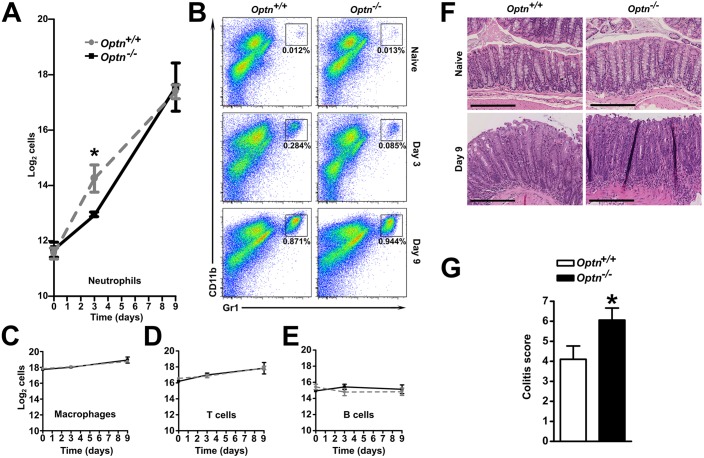
OPTN-deficient mice recruit fewer neutrophils during the early acute phase of Citrobacter infection, resulting in a more severe colitis. (A) Large bowel from naïve mice, day 3 and day 9 after Citrobacter inoculation, were digested and flow cytometry for CD11b+ Gr1+ neutrophils was performed (n=10-11 mice/genotype over 3 experiments). (B) Representative flow cytometry plots for CD11b+ Gr1+ neutrophils in naïve mice, day 3 and day 9 after Citrobacter inoculation, are shown with percentage of neutrophils. (C) Flow cytometry for CD11b+ F4/80+ macrophages, (D) CD3+ T cells and (E) CD19+ B cells in large bowels from naïve mice, day 3 and day 9. (F) Representative image of haematoxylin and eosin (H&E)-stained naïve and day 9 after Citrobacter inoculation large bowel tissue (20× magnification, scale bar: 200 µm). (G) Blinded colitis scoring of H&E-stained large bowel sections at day 9 in Optn+/+ and Optn−/− mice (n=17-20 mice/genotype, over 2 experiments). Results shown are mean±s.e.m. (*P<0.05; two-tailed, unpaired t-test).